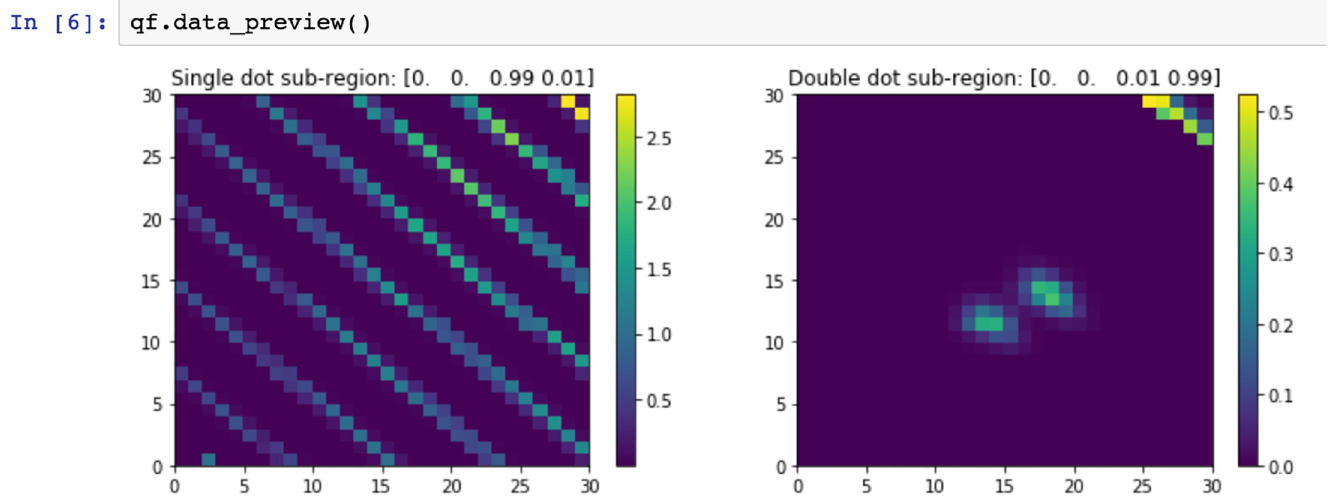
Fig 6. A sample preview output. A preview of a single dot (left) and of a double dot subregion (right) generated using a QFlow lite build-in function qf. data_preview() . The labels printed above images indicate the actual state, as well as the fraction of each type of state within the given image in the format: [SC, QPC, SD,